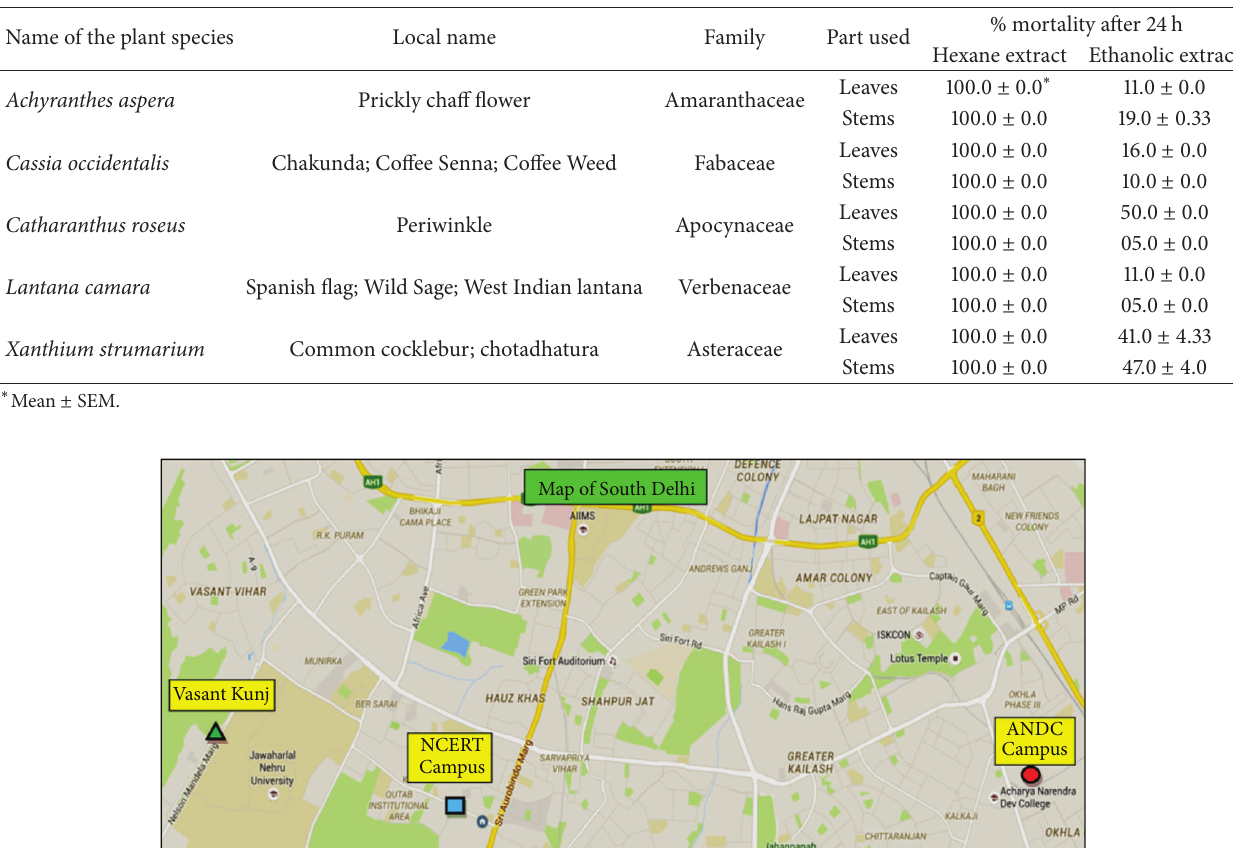
Table 1: Screening of the 1000ppm hexane and ethanol extracts of five plant species for their larvicidal activity against early fourth instars of dengue vector Aedes aegypti .